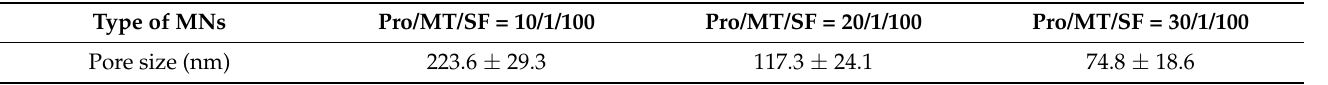
Table 1. Pore size of Pro/MT/SF in different